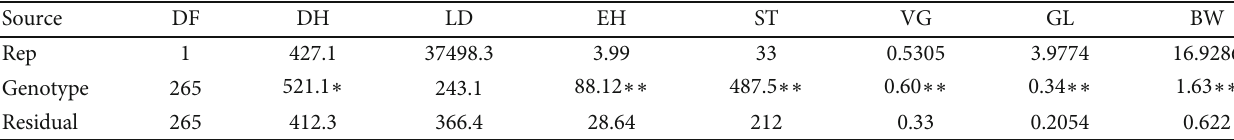
Table 4: Mean squares for Busseola fusca damage and morphological traits at the Kabete site.